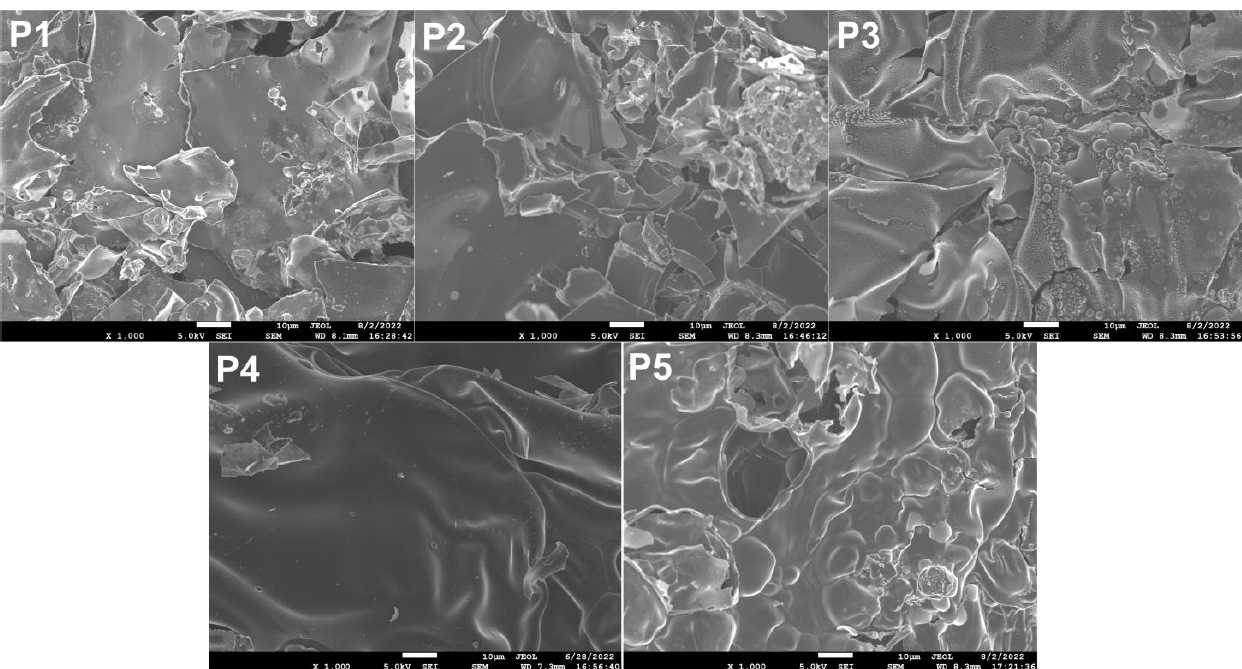
Figure 11. SEM image of surface carbon